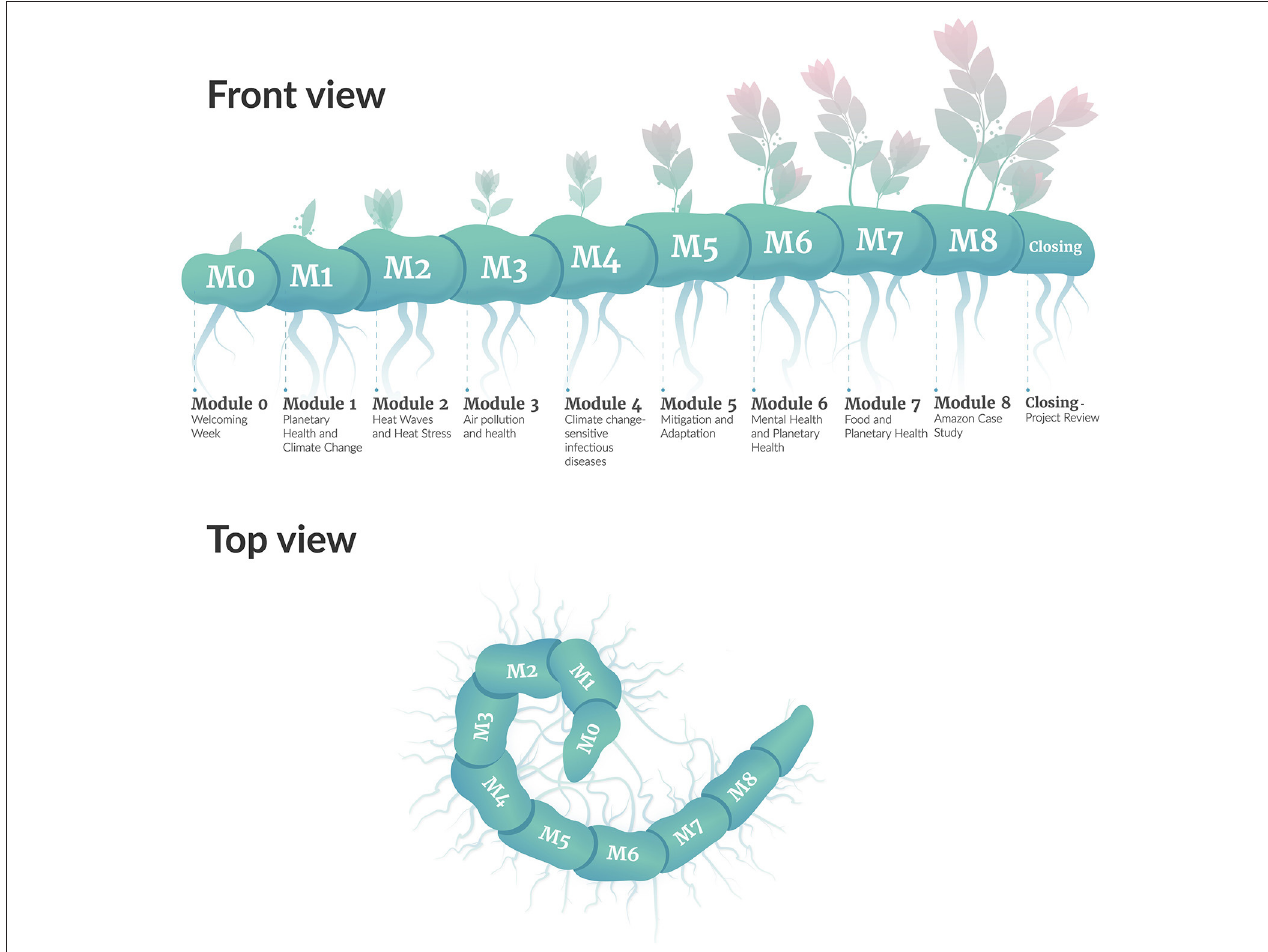
FIGURE 1 | Rhizomes and rhizomatic course structure. Illustration credit: Iasmine Paim Nique da Silva and Lorenzo Costa